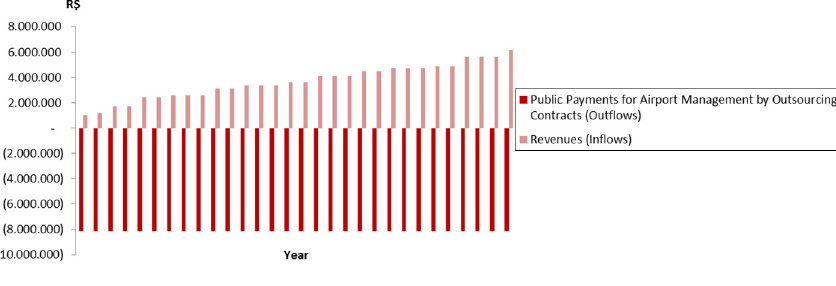
Figure 4. Project cash fl ow in